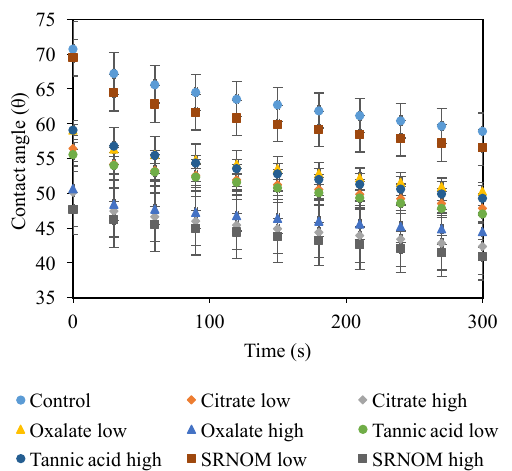
Figure 5. Dynamic contact angles of experimental solutions for control (NaCl + HNS), plant exudates (citrate and oxalate), and soil components (tannic acid and organics: Suwanee River natural or- ganic matter, SRNOM). Averages are graphed, and associated error bars represent 1 standard